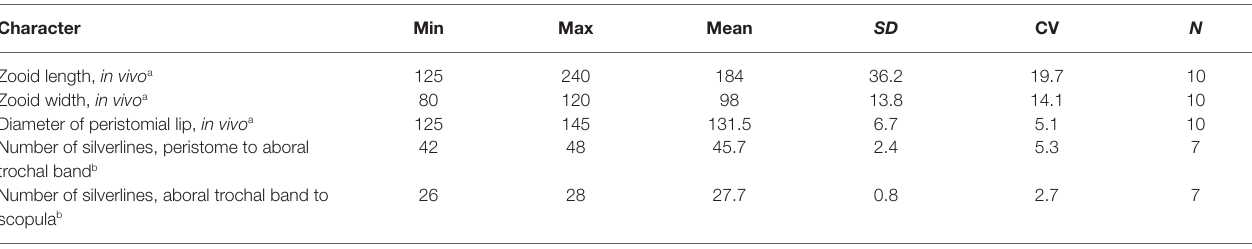
TABLE 2 | Morphometric data of Campanella sinica n. sp.